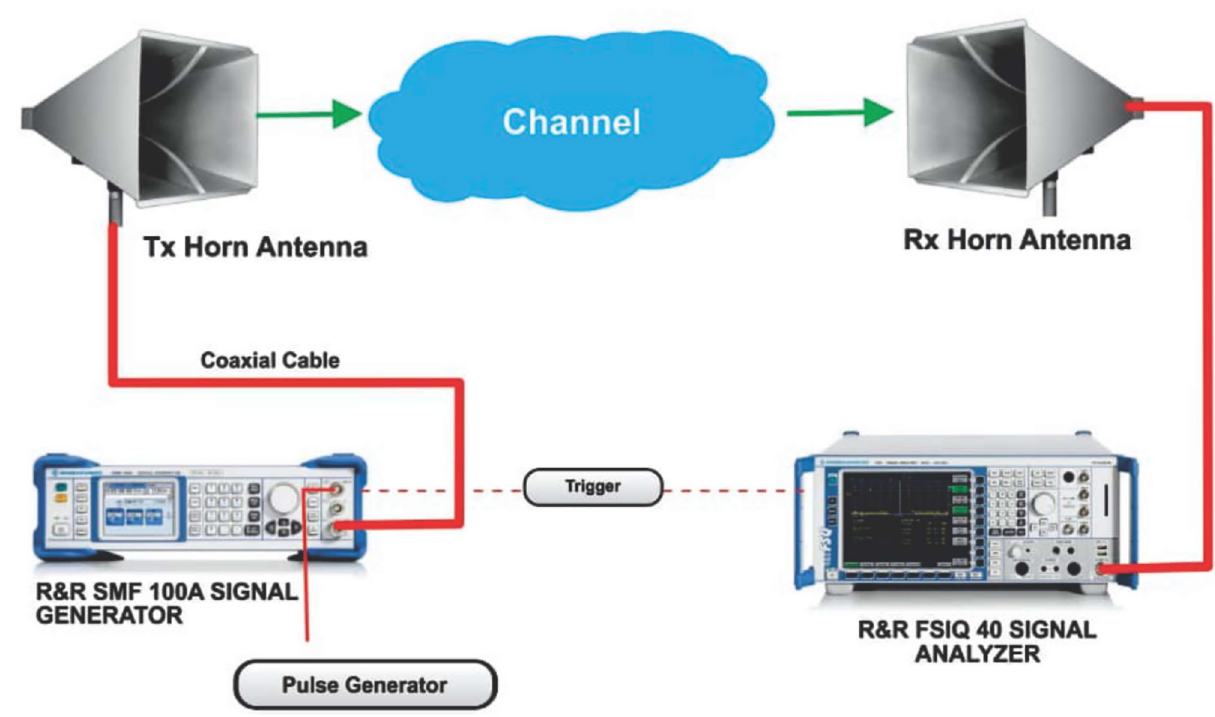
Fig 2. The channel sounder’s architecture.